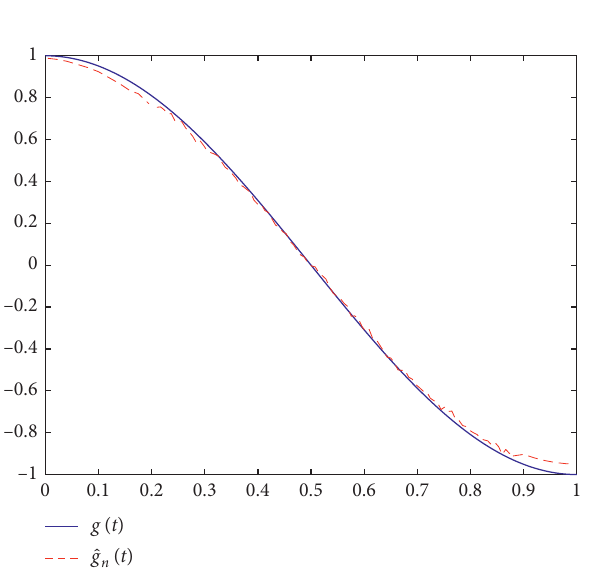
Figure 4: Curves of g ( t ) � cos ( π t ) and 􏽥 g n �